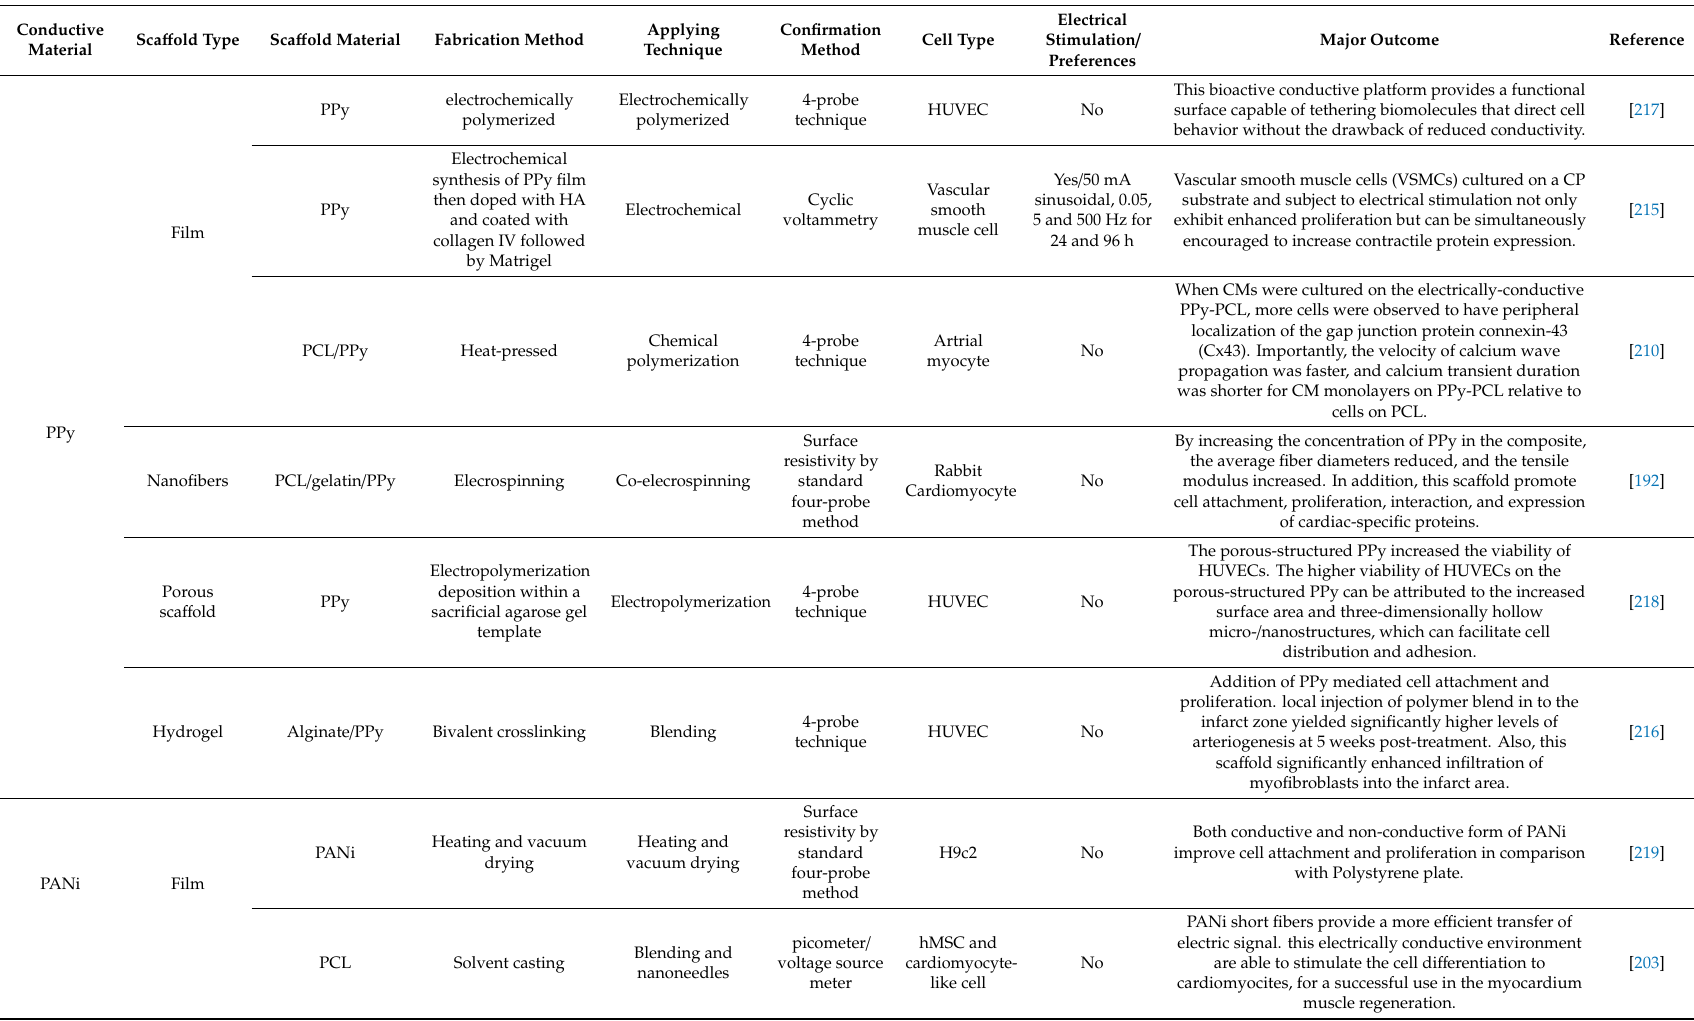
Table 3. Conductive sca ff olds used in cardiovascular tissue